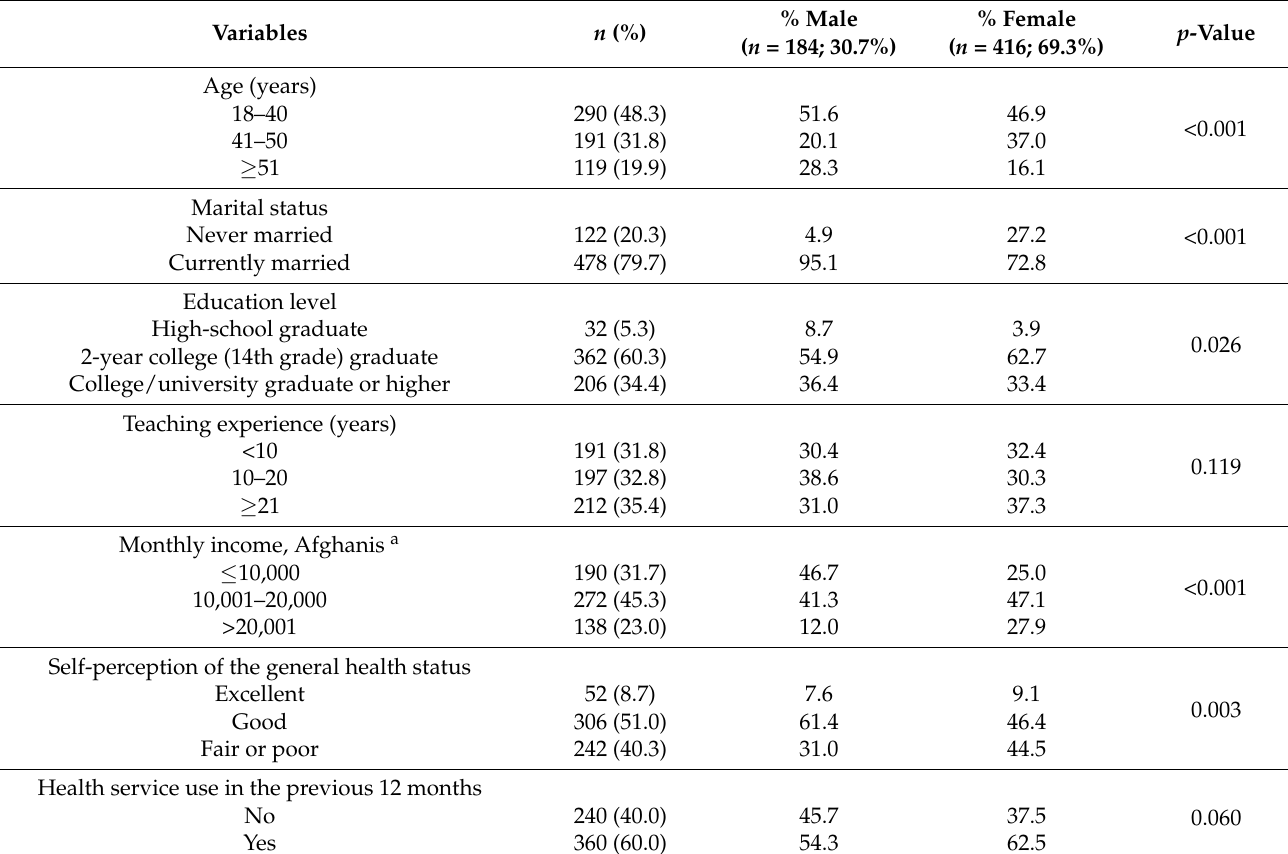
Table 1. Characteristics of participants stratified by gender among schoolteachers in Afghanistan ( n = 600).